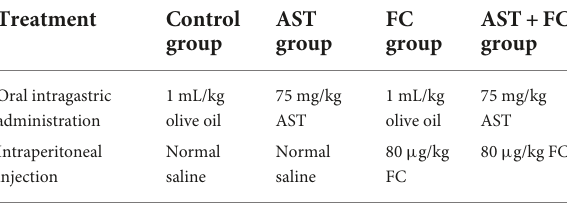
TABLE 1 Group and